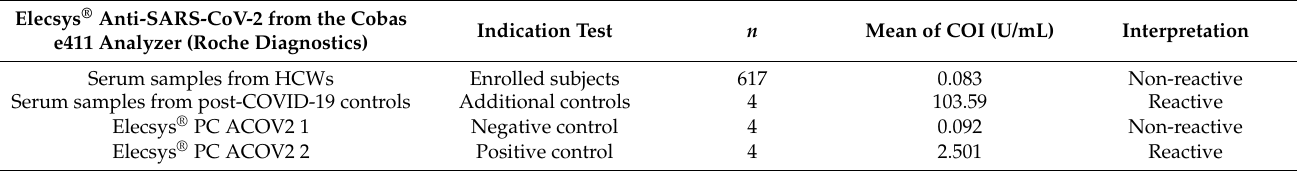
Table 3. Detection of anti-SARS-CoV-2 nucleocapsid total antibodies from HCWs ( n = 617).